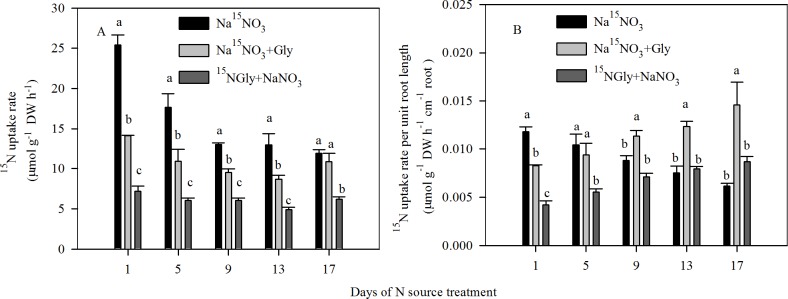
(A)
15N uptake rate and (B)
15N uptake rate per unit root length over time for pak choi seedlings exposed to Na15NO3, Na15NO3
+ Gly or
15NGly + NaNO3. Data are mean ± SE (n = 3). Different letters indicate significant differences between treatments at P < 0.05, LSD test.